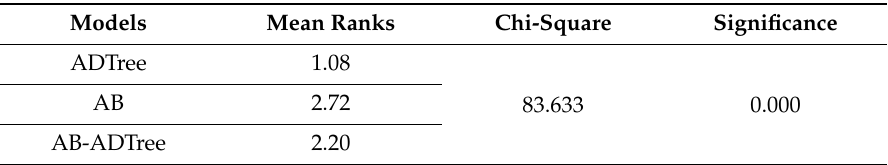
Table 4. Friedman test statistics results for this study.